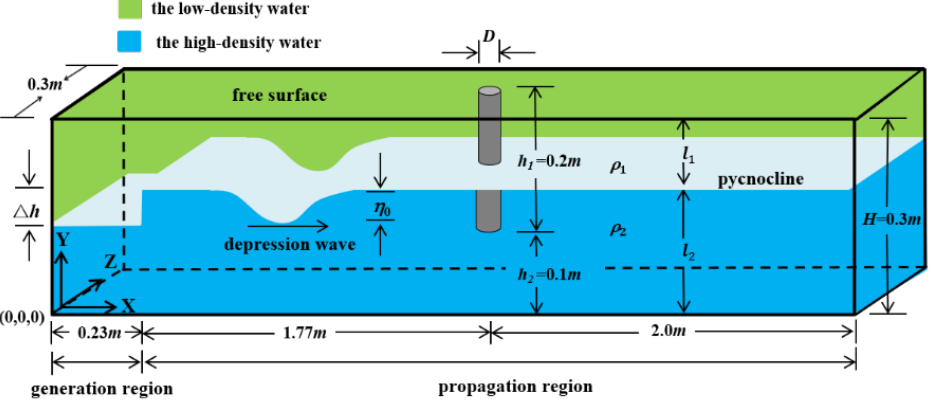
Figure 1. Sketch map of the single cylinder (SC) numerical model.